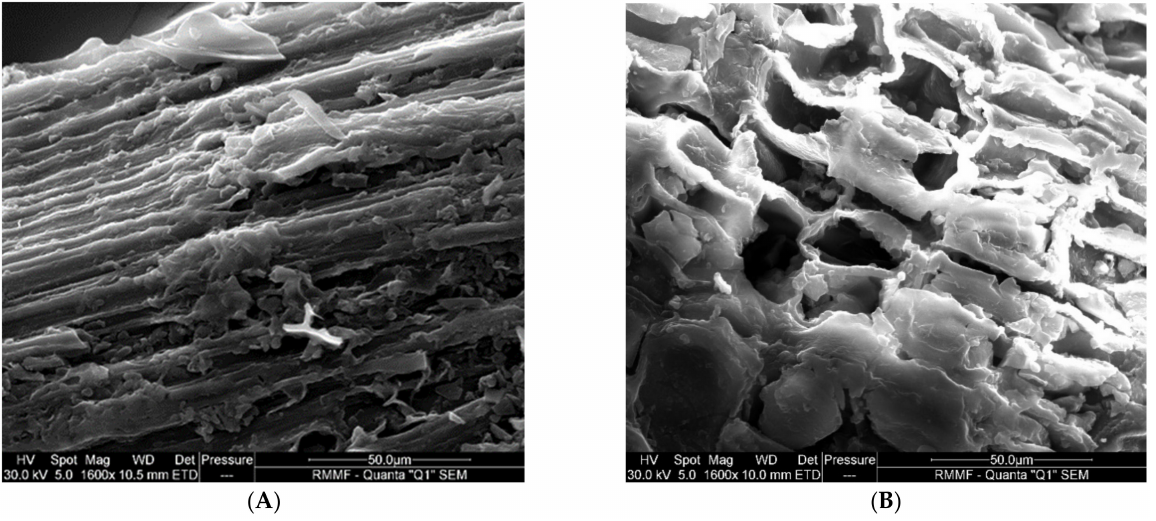
Figure 3. Scanning electron microscopy images of wood biochar ( A ) and treated-wood biochar ( B ).